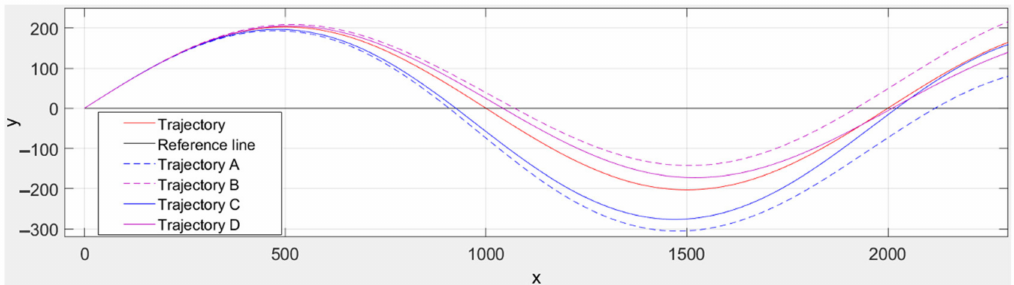
Figure 10. Error type II